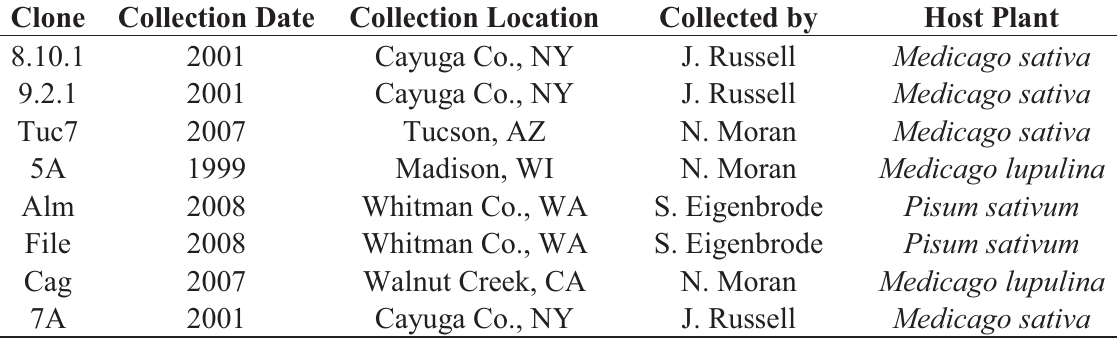
Table S1. Aphid collection information.